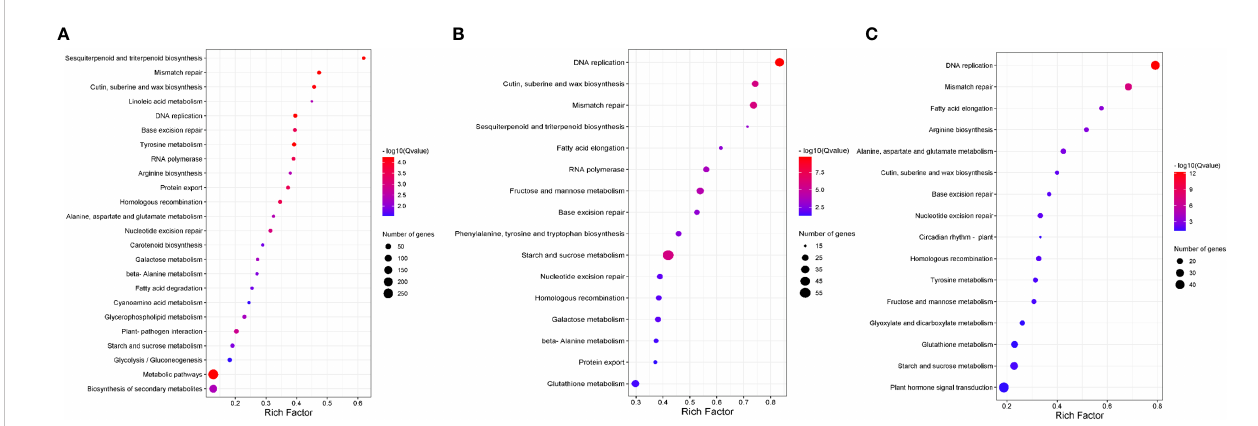
FIGURE 2 The Kyoto Encyclopedia of Genes and Genomes (KEGG) pathway enrichment analysis of unigenes with higher expression in the S3 stage. The signi fi cantly enriched pathways with corrected p-value (q value) < 0.05 are shown. The number indicates the size of the dot, describing the number of unigenes enriched in the pathway. The color bar represents the RF value and indicates the signi fi cance of the enrichment. (A) KEGG enrichment pathways of the DEGs were exclusively detected in P12 vs . N5. (B) KEGG enrichment pathways of the DEGs exclusively detected in N5 vs . N4. (C) KEGG enrichment pathways of the DEGs were exclusively detected in P12 vs .